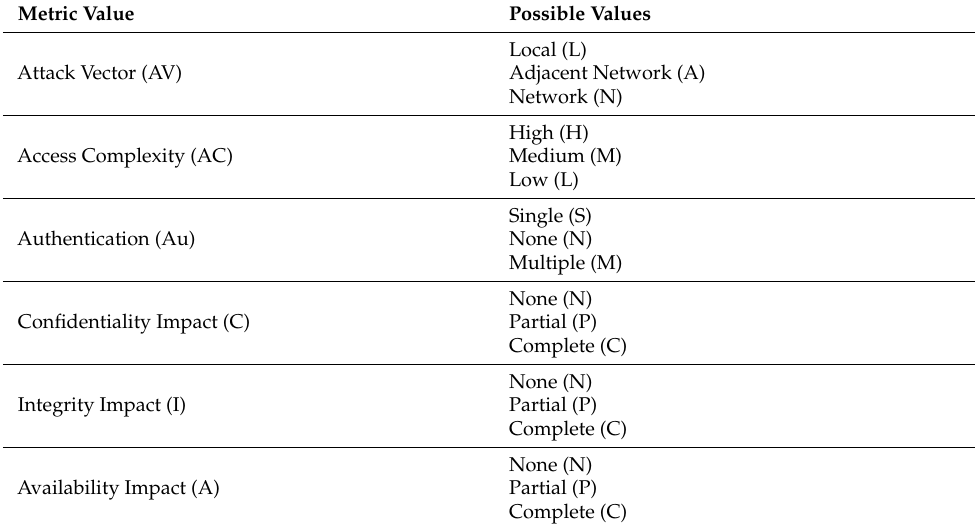
Table 2. Possible values for the base metric group of the CVSS v2 standard.